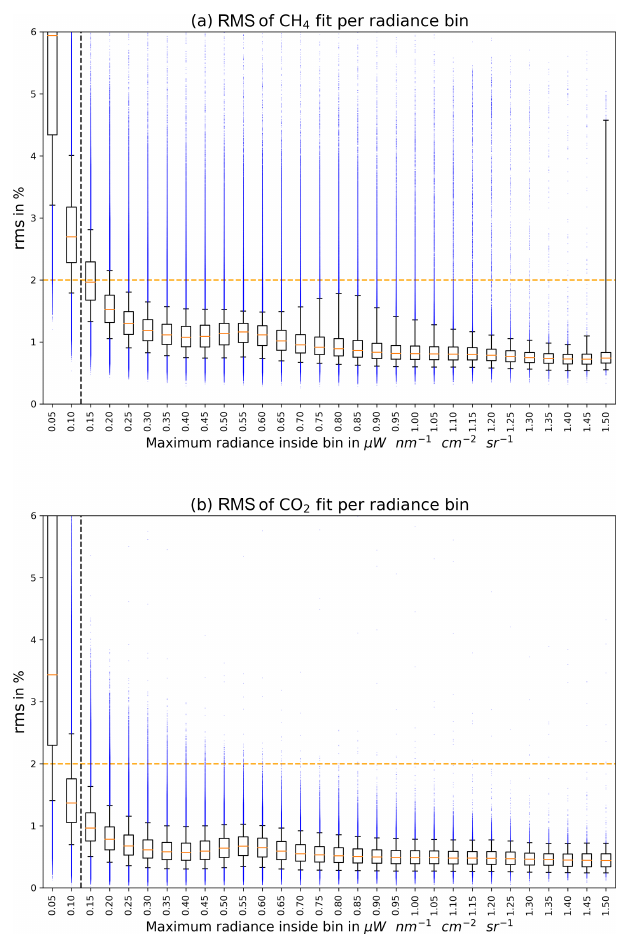
Figure 6. Difference between fit and measurement (RMS) over ra- diance at 2140 . 0nm. The box indicates the first to third quartile range, the whiskers denote the 5th to 95th percentiles, and the small orange line inside the box is the median RMS value of the accord- ing radiance bin. The small blue dots denote outliers outside the 95th percentile. For low radiances, the fitting quality decreases sig- nificantly. Therefore, all measurements over surfaces with radiances below 0 . 1µWcm − 2 nm − 1 sr − 1 are filtered out (dashed black ver- tical line). Results with RMS higher than 2% are filtered out as an additional quality flag (dashed orange line).